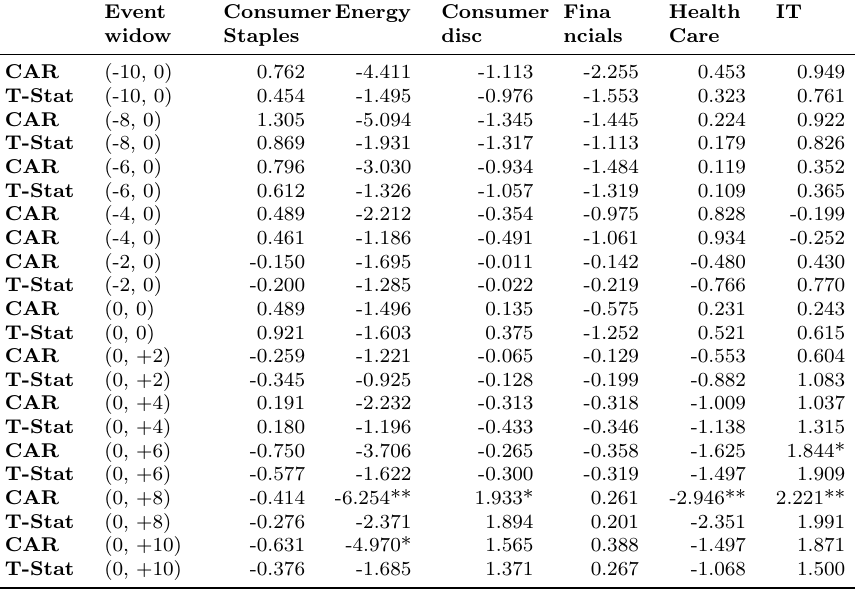
Table 1: First confirmed COVID-19 Case and Reaction of different US Sectors Event Consumer Energy Consumer Fina Health widow Staples disc ncials Care